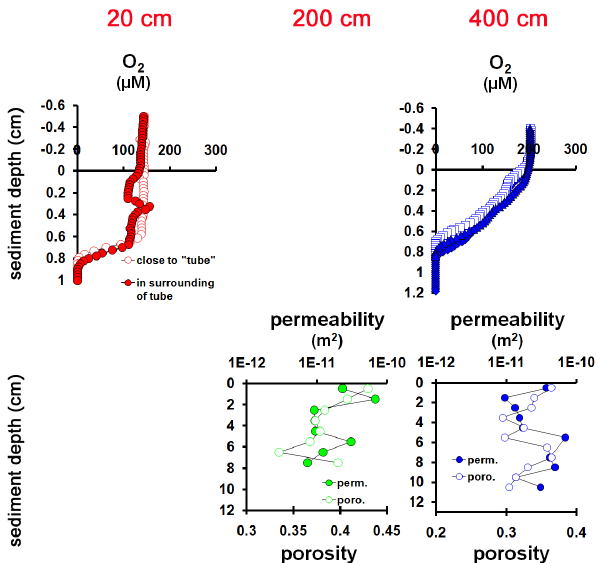
Fig. 1a. Biogeochemical profiles of the April sampling (transect) at Brian Seep: oxygen (2 replicates), permeability, and porosity. Sam- ples were available from 20 (red), 200 (green), and 400cm (blue) distance from the gas vent. The oxygen profiles were taken in the surrounding and close to a small tube, which could originate, e.g., from polychaetes living in the sediment.